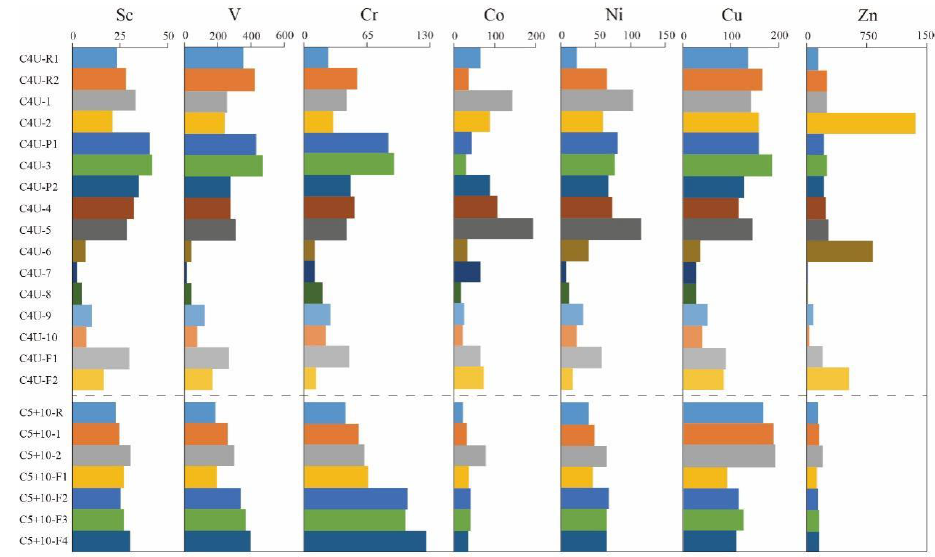
Figure 5. Vertical changes in contents of transitional metal elements of the two coal seams. Note: Above the dashed line these samples are from the C4-Upper coal seam. Under the dashed line these samples are from C5 + 10 coal samples. All the elements are coal-basic, and the unit of abscissa is µg/g.